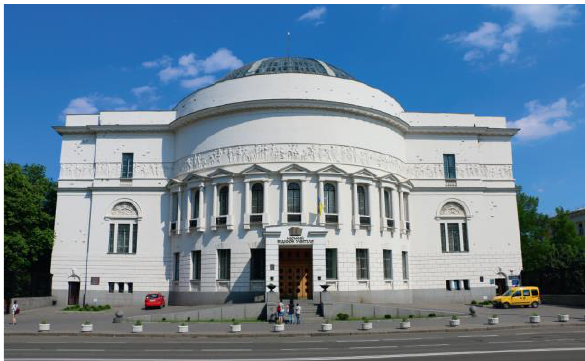
Figure 2 . Kyiv Teacher’s House front facade